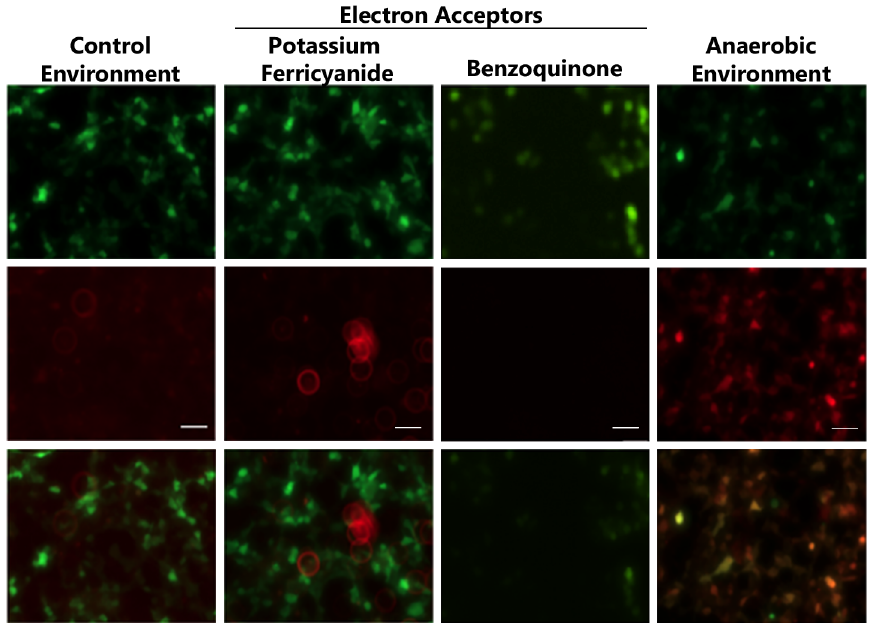
Fig 4. The efficiency of GCaMP3 photoconversion in HEK293 cells is dramatically enhanced under low-oxygen condition. GCaMP3-expressing HEK293 cells were illuminated first under control culture conditions, with the presence of electron acceptor potassium ferricyanide or benzoquinone (both at 5mM), or under low-oxygen conditions created by treating the cells with 30 μ g/ml catalase, 4.5mg/ml glucose and 250 μ g/ml glucose oxidase for 30 minutes. Cells were then exposed to blue light for 2 minutes. Green (top), red (middle) and merged (bottom) fluorescent micrographs. Scale bar: 20 μ